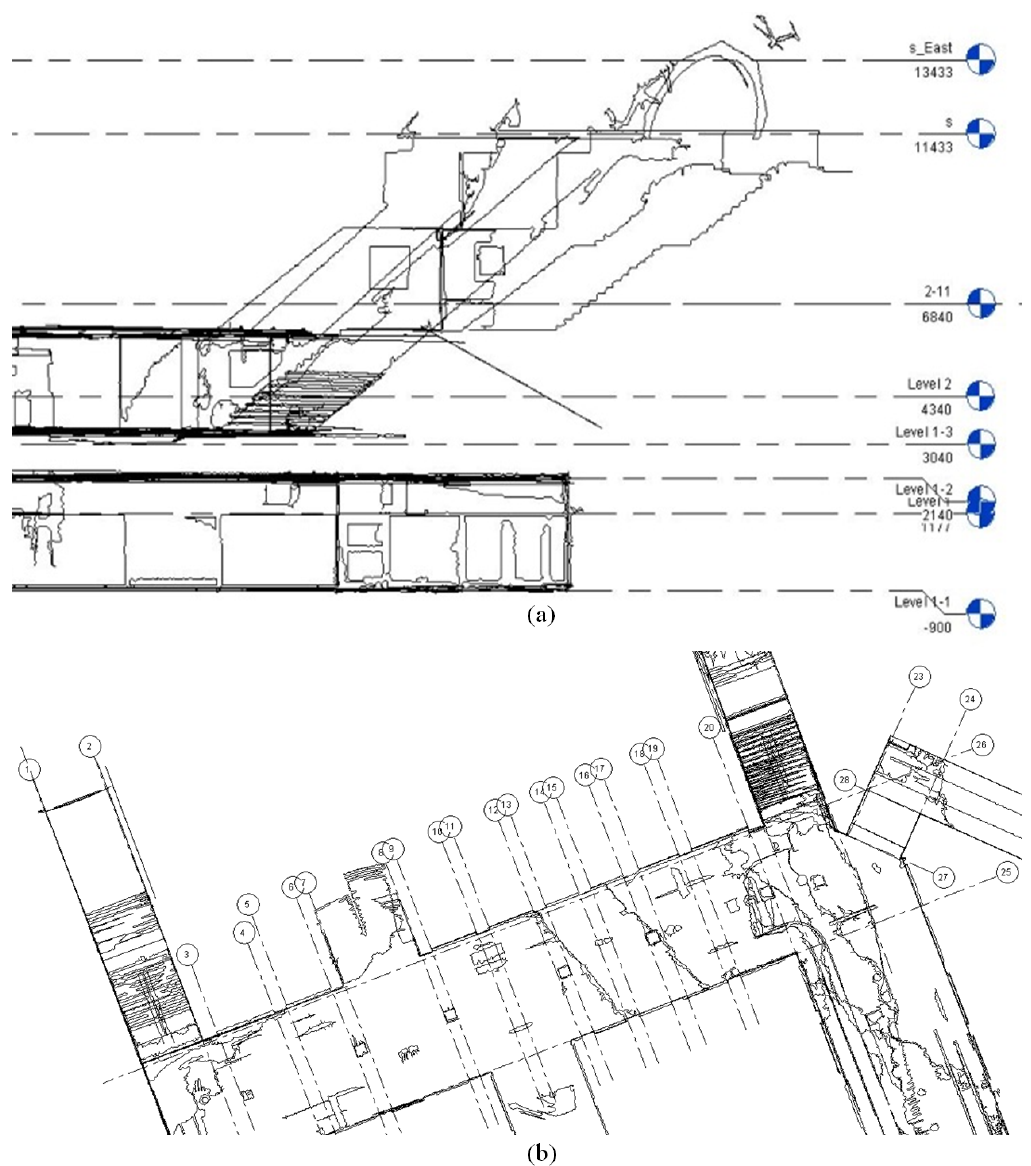
Figure 5. Level and grid line creation: ( a ) Created level line and ( b ) Created grid line. Figure 6. Level and grid line creation: ( a ) Created level line and ( b ) Created grid